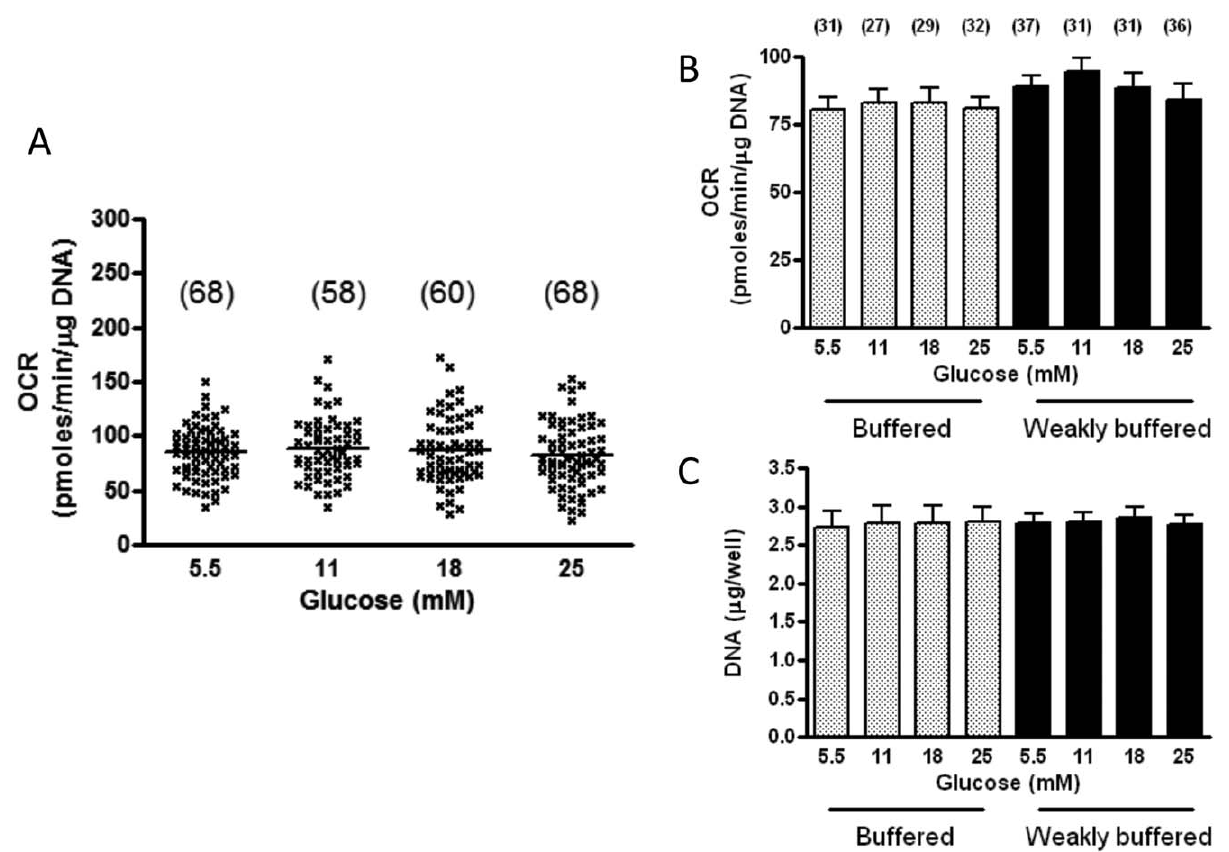
Figure 2. Effect of glucose on oxygen consumption rates (OCR) in BAE cells during basal incubation. Cells were grown to confluency and exposed overnight (18 h) to the glucose concentrations indicated. Respirometer experiments were carried out in weakly buffered (phosphate) medium as recommended by the manufacturer (Seahorse, Inc) for simultaneous detection of OCR and ECAR or in the same medium buffered with 25 mM HEPES. A) Basal OCR, all data (scatterplot with median value); B) Basal OCR (mean 6 SE) in cells incubated in buffered or weakly buffered medium; C) DNA content per well (mean 6 SE) in cells depicted in panel B. Glucose had no significant effects on OCR or DNA whether analyzed by ANOVA or multiple t-tests. Incubation in buffered compared to weakly buffered medium had no significant effects at any glucose concentration. Numbers in parentheses indicate number of repetitions.